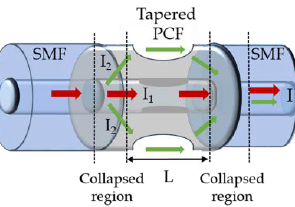
Figure 25. Schematic diagram of the magnetic field sensor based on a tapered PCF (adapted from [80]).